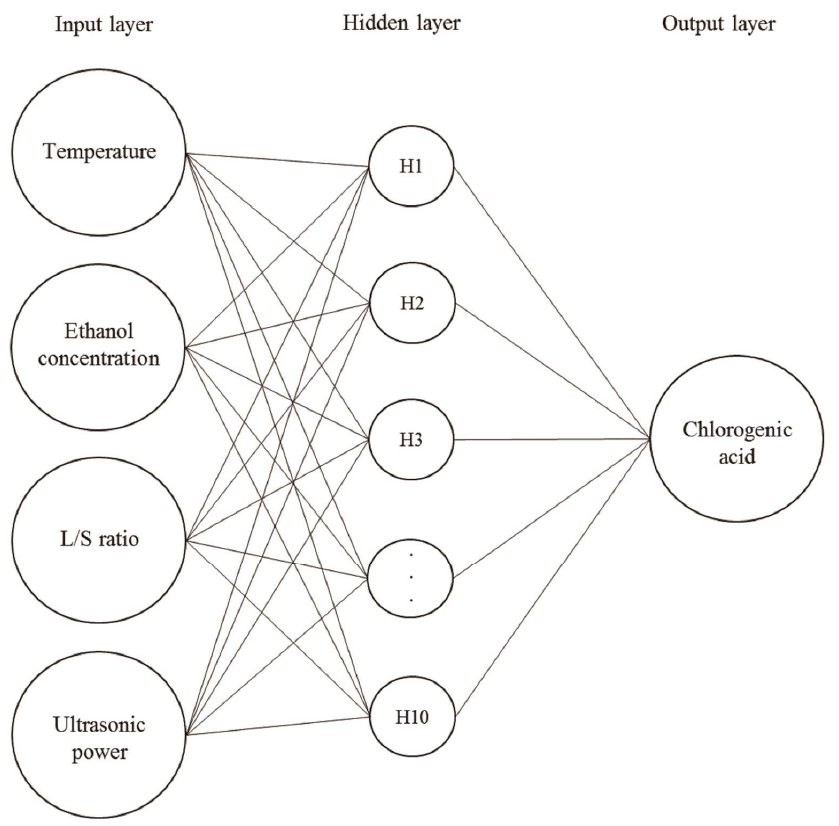
Figure 2. Neural network topology. The topology of multilayer feed forward neural network for the estimation of ultrasound-assisted extraction of chlorogenic acid (CGA).